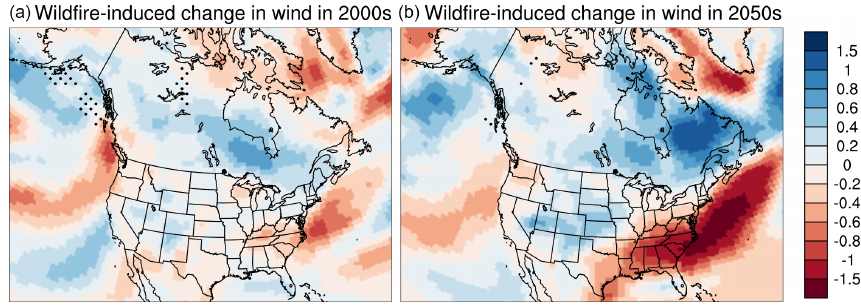
Figure 5. Spatial distribution of decadal-mean summer (JJA) wildfire-induced future changes ((2050 ALL –2050 WEF )–(2000 ALL –2000 WEF )). (a) Wind speed below 850hPa for 2050 ALL –2000 ALL , (b) wind speed below 850hPa for 2050 WEF –2000 WEF . The unit is meters per second. The grids with statistical significance of 90% are identified by black